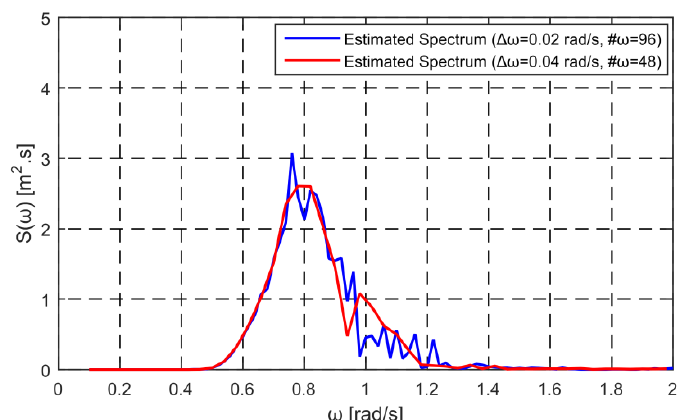
Figure 21. Comparison of estimated spectra averaged over 700~1000 s for the different number of frequency components.